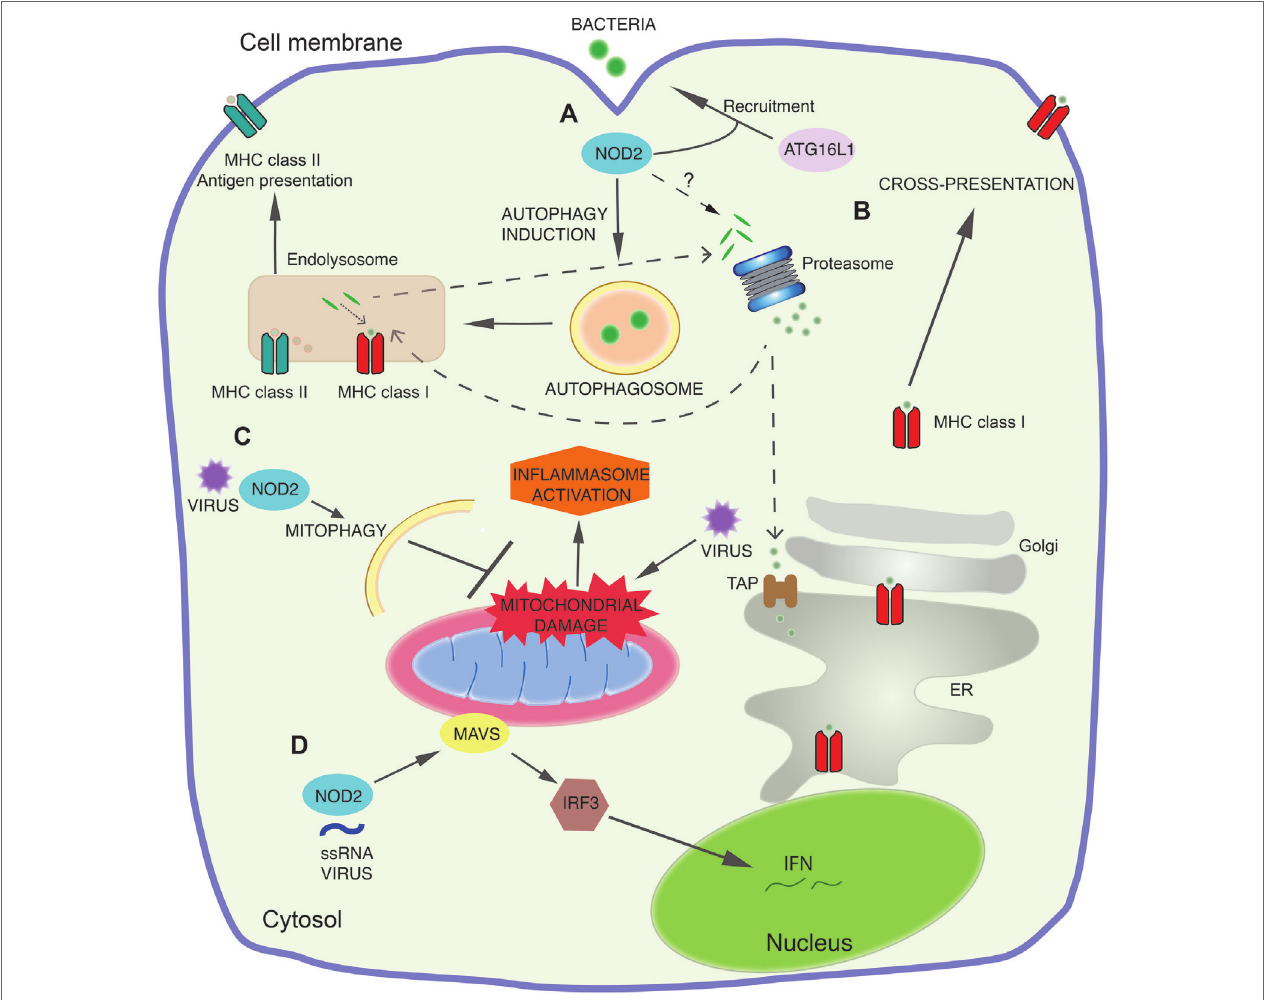
FiGURe 1 | NOD2 signaling pathways. (A) At sites of bacterial entry to the cell cytosol, NOD2 recruits the autophagy protein autophagy-related 16-like 1 (ATG16L1) to the plasma membrane and together they direct autophagy of the invading bacteria. This leads to both direct bacterial killing and loading of the antigens to major histocompatibility complex class II (MHC II). (B) Early NOD2 engagement by components of bacteria increases cross-presentation for MHC class I-dependent antigen presentation. Antigens destined for cross-presentation can have different routes: they can be transported from the endocytic vesicles to the cytosol for proteasomal degradation and transported into the endoplasmic reticulum (ER) or back into the endosomal compartment for loading onto MHC class I. The molecular mechanisms by which NOD2 controls these pathways and proteasome function are still not defined. (C) NOD2 also functions as a viral pattern- recognition receptor and modulates immune response to viral infection. NOD2 drives RIPK2-mediated mitophagy of damaged mitochondria following viral invasion of the cytosol. This negatively regulates the NLRP3 inflammasome response by limiting the release of mitochondrial reactive oxygen species and other mitochondrial damage-associated molecular patterns following the mitochondrial damage caused by viral infection. (D) NOD2 recognizes viral ssRNA to trigger mitochondrial antivirus signaling protein (MAVS) mediated activation of interferon regulatory factor 3 (IRF3), leading to production of the antiviral interferon (IFN)